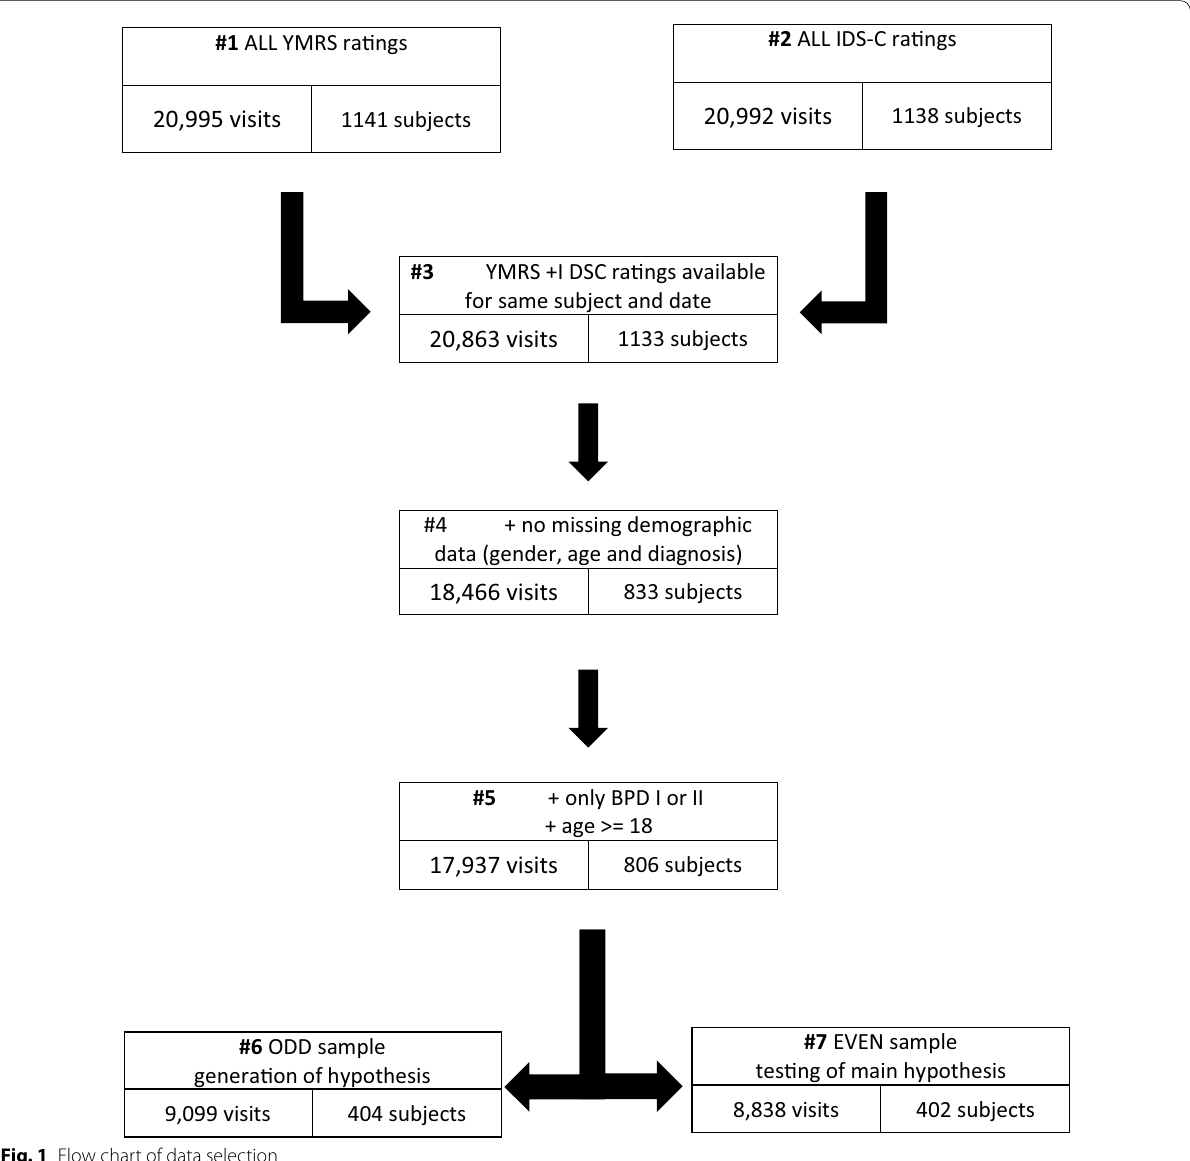
Fig. 1 Flow chart of data